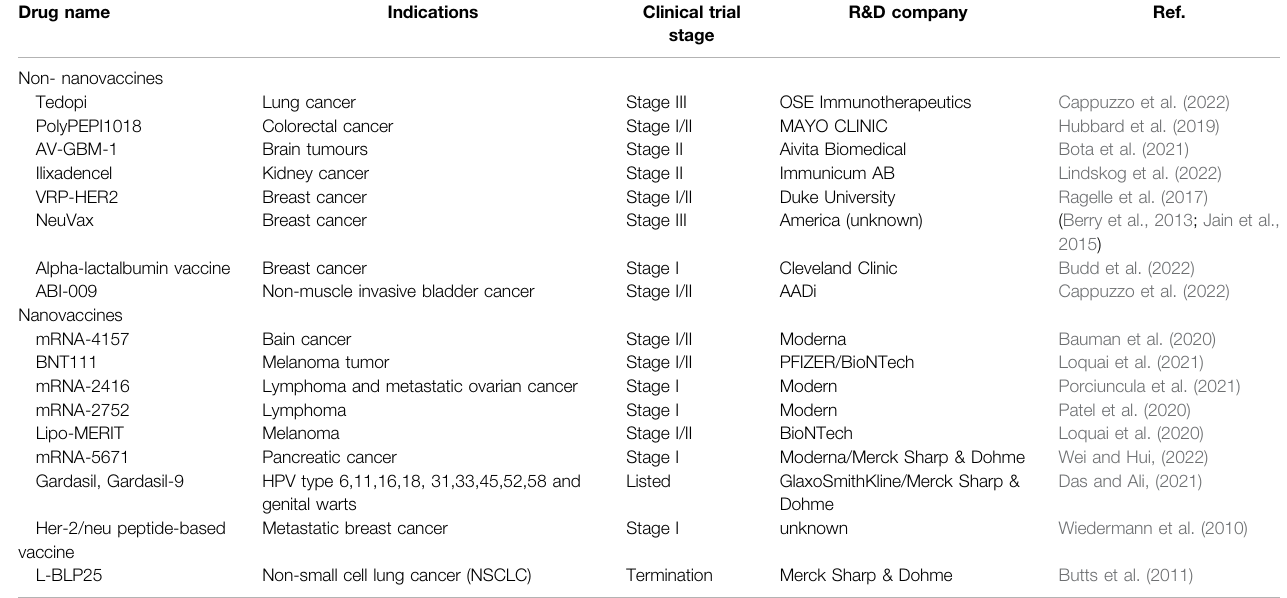
TABLE 4 | Cancer vaccines that are in the clinical trial